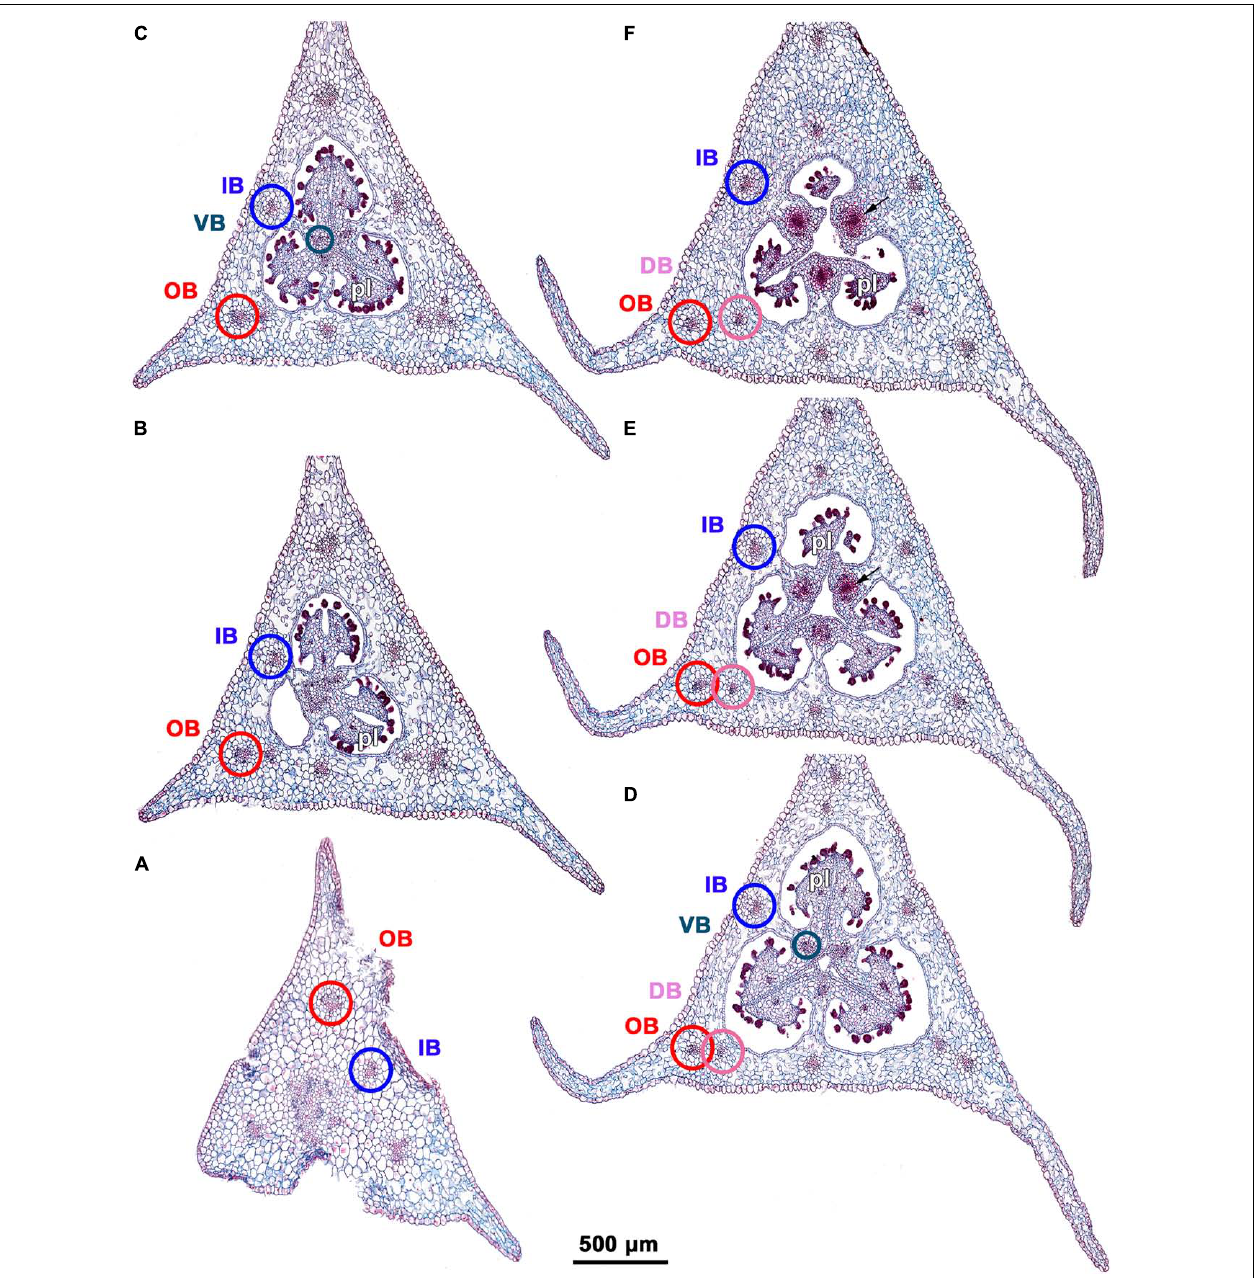
FIGURE 3 | Ascending series of transverse microtome sections of flower bud of Burmannia disticha (LM). (A) Pedicel just below ovary. (B) Proximal (secondarily trilocular) portion of symplicate zone of ovary. (C) Middle (secondarily trilocular) portion of symplicate zone of ovary. (D–F) Distal (unilocular) portion of symplicate zone of ovary. Arrow indicates septal nectary. pl, placenta; DB, dorsal bundle; IB, inner bundle; OB, outer bundle; VB, ventral bundle.